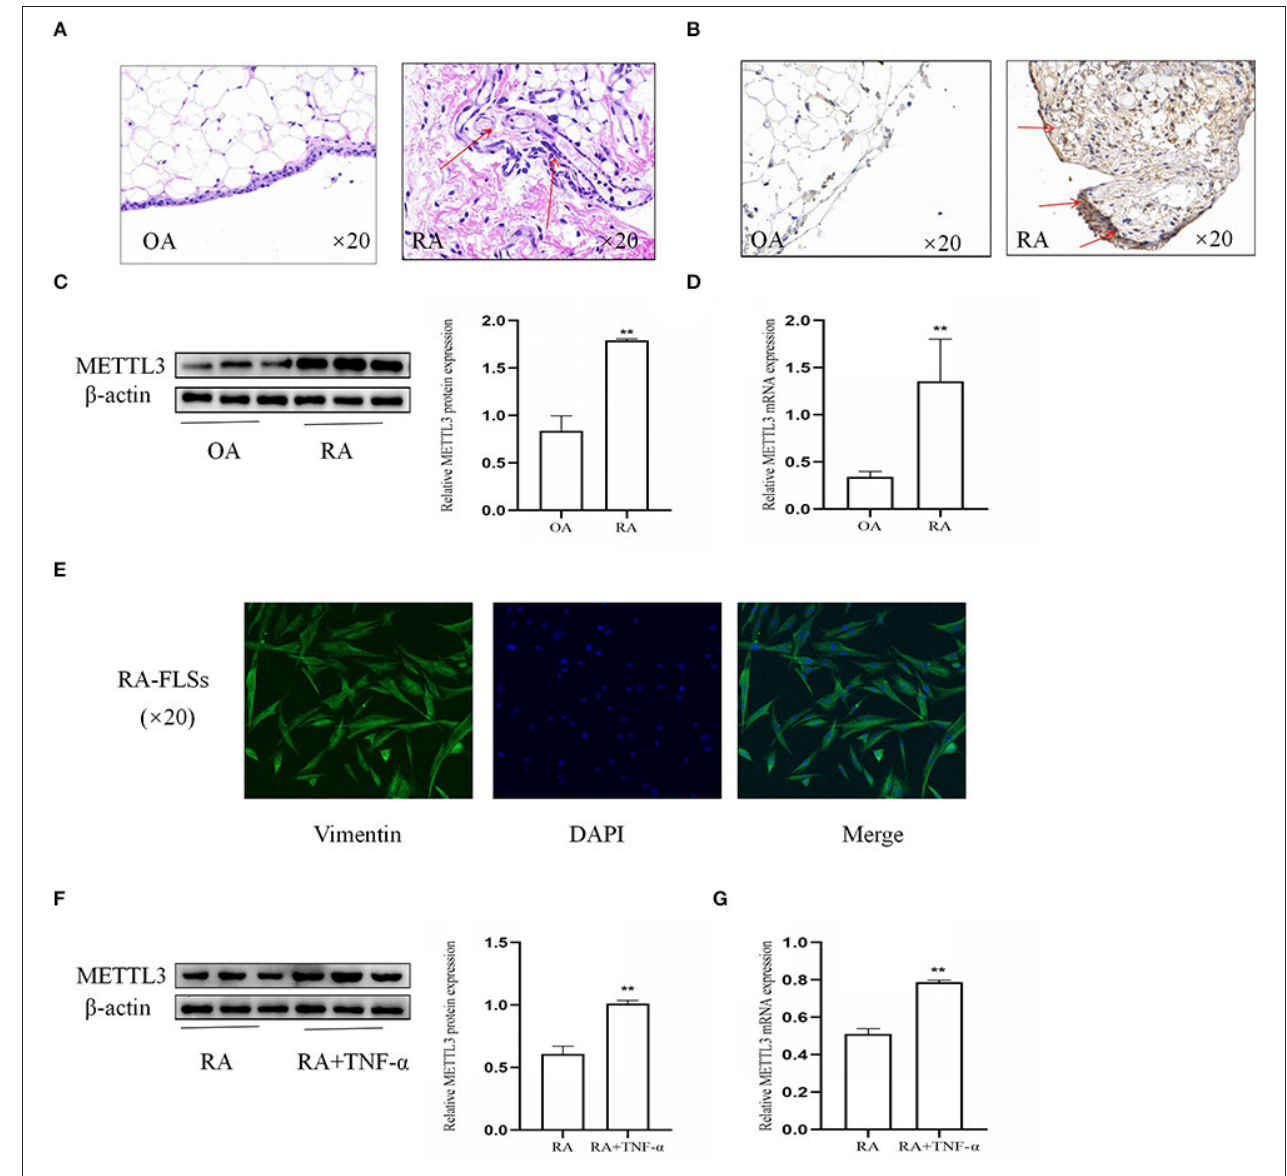
FIGURE 1 | Methyltransferase-like 3 (METTL3) was obviously upregulated in rheumatoid arthritis fibroblast-like synoviocytes (RA-FLSs). (A) H&E staining was used to analyze synovial tissues (shown as red arrows ) from RA and osteoarthritis (OA) patients (original magnification, × 20). (B) METTL3 expression in synovial tissues (shown as red arrows ), as detected by immunohistochemical staining (original magnification, × 20). (C) Western blotting was used to detect METTL3 protein level in synovial tissues. (D) METTL3 mRNA levels in OA and RA synovial tissues, as detected by real-time quantitative PCR (qPCR). (E) Vimentin expression, as detected by immunofluorescence (original magnification, × 20); the extracted cells were verified to be RA-FLSs. (F) METTL3 protein levels in RA-FLSs after treatment with TNF- α , as detected by Western blotting. (G) METTL3 mRNA levels in RA-FLSs after TNF- α incubation, as detected by qPCR. All of these values are presented as the mean ± SD. OA , osteoarthritis. ** P < 0.01 vs. the OA control